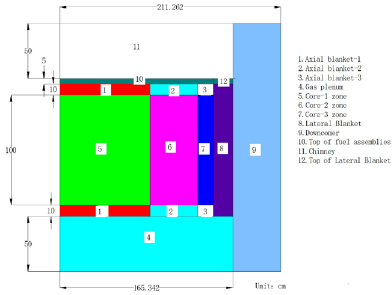
Figure 2. Geometry model of the RBEC-M reactor